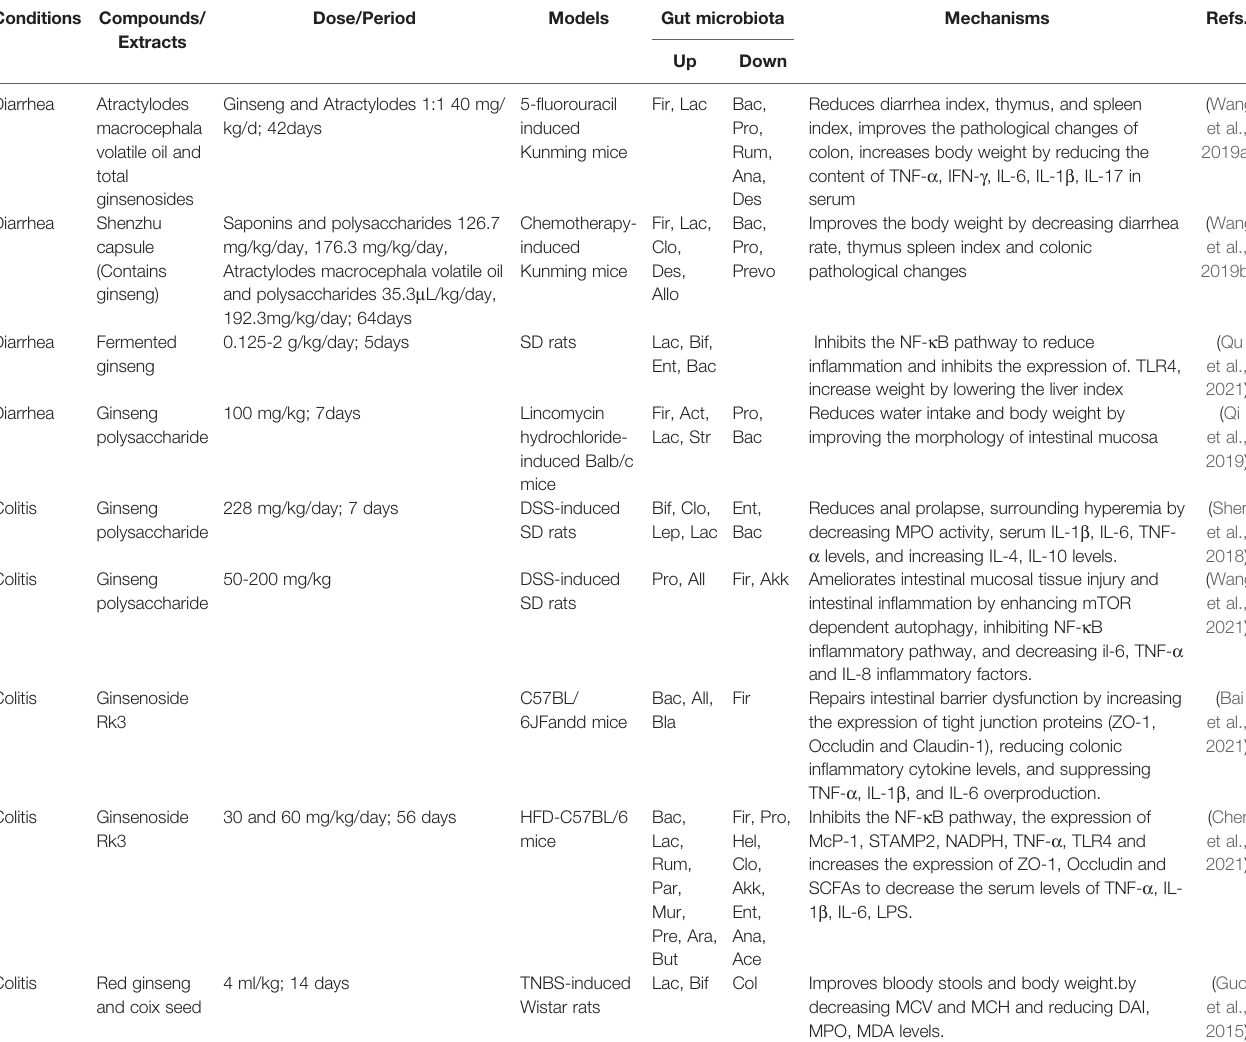
TABLE 4 | Summary of anti-colitis and anti-diarrhea activities of ginseng by regulating gut microbiota and related pathways. Conditions Compounds/